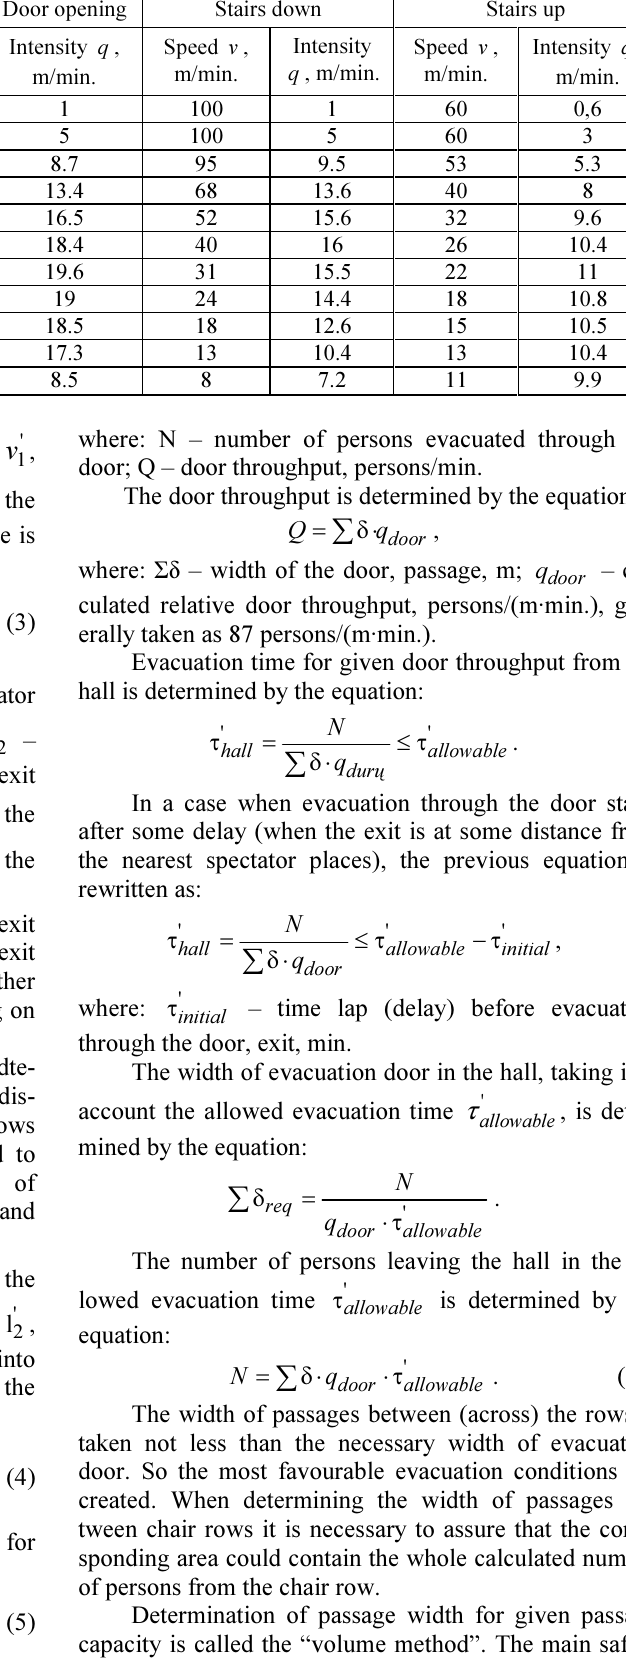
Intensity q , m/min.